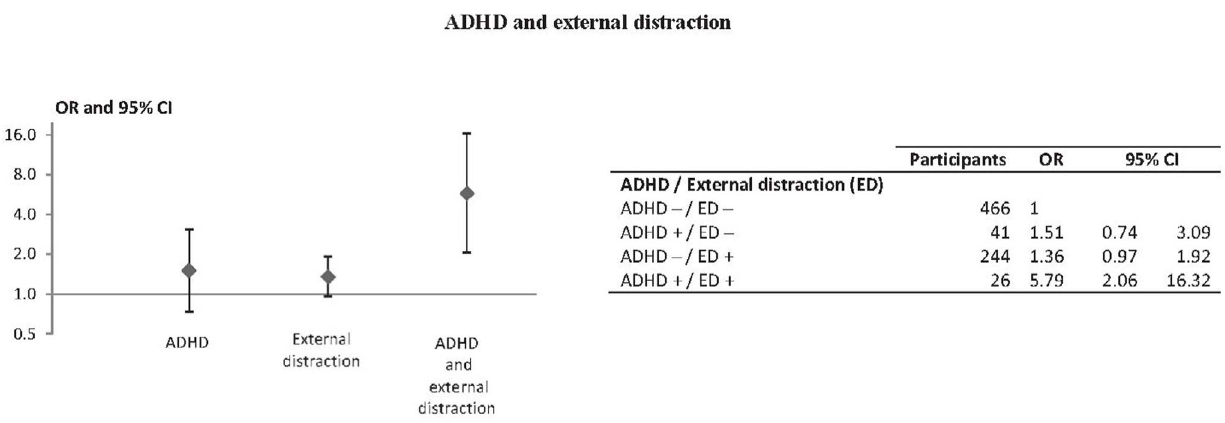
Fig. 1. Association of ADHD and external distraction with driver responsibility, multivariate logistic regression (n 5 777). Adjusted for internal distraction, alcohol use, psychotropic drug use, sleep deprivation, professional driver, gender, age, depressive disorders and anxiety disorders. ( + ) and ( 2 ) represent presence or absence of the risk factor.